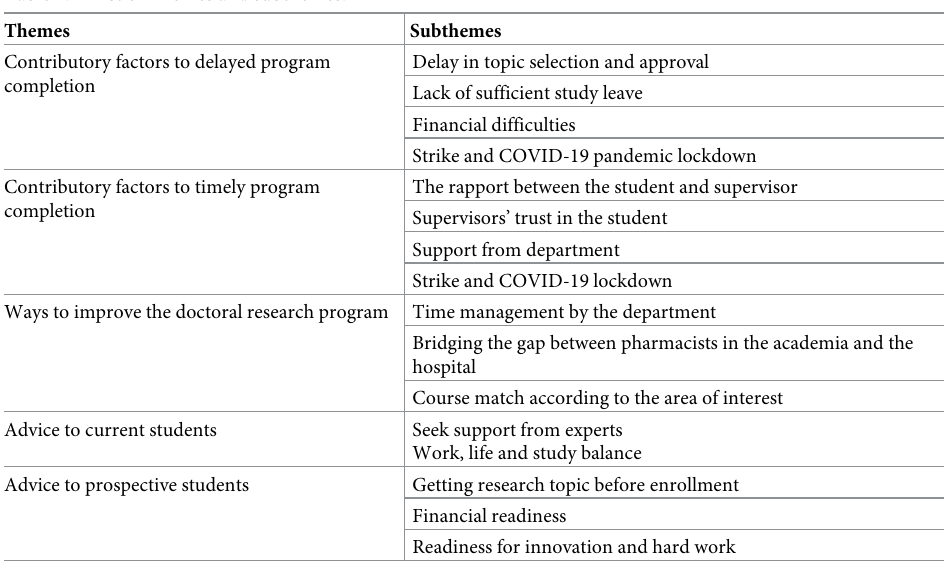
Table 4. A list of Themes and